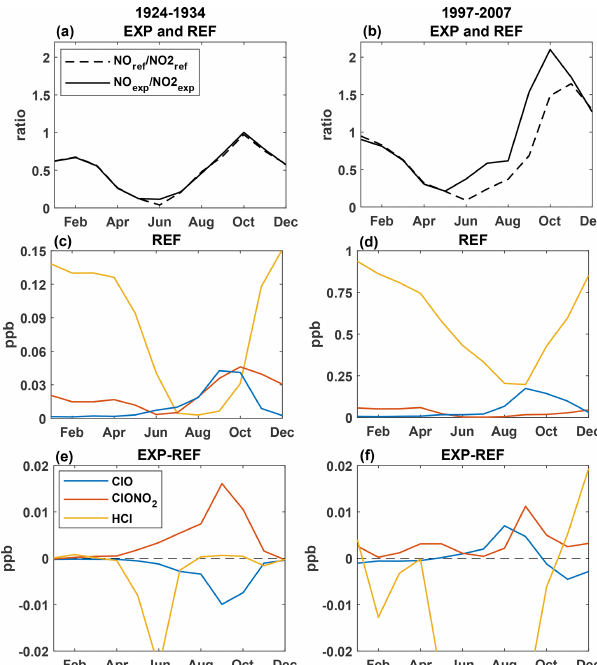
Figure 11. (a) Seasonal polar NO / NO 2 ratio at 100hPa in EXP (solid line) and REF (dashed line) during 1924–1934, and (b) dur- ing 1997–2007. (c) Seasonal REF polar 100hPa climatology of ClO (blue), HCl (yellow) and ClONO 2 (red) during 1924–1934, and (d) during 1997–2007. Note the different y axes in (c) and (d) . (e) Seasonal EXP − REF polar ClO (blue), HCl (yellow) and ClONO 2 (red) at 100hPa during 1924–1934, and (f) during 1997–